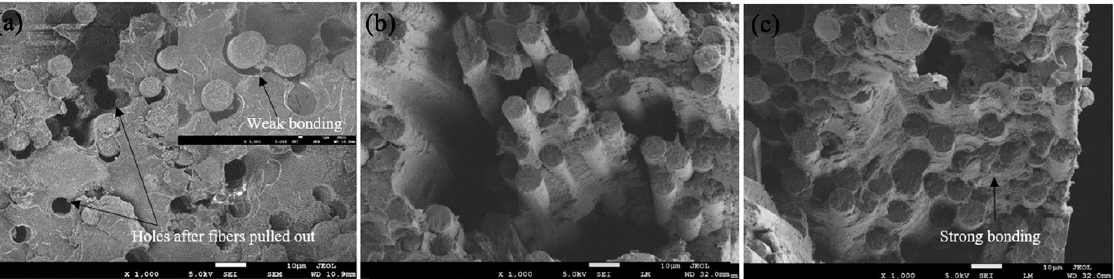
Figure 6. SEM images of flexural-tested CF/PEEK composites after fracture: ( a ) bare fibre without sizing, ( b ) PEI+GO1, ( c ) PEI+GO10 (reprinted with permission) [26].